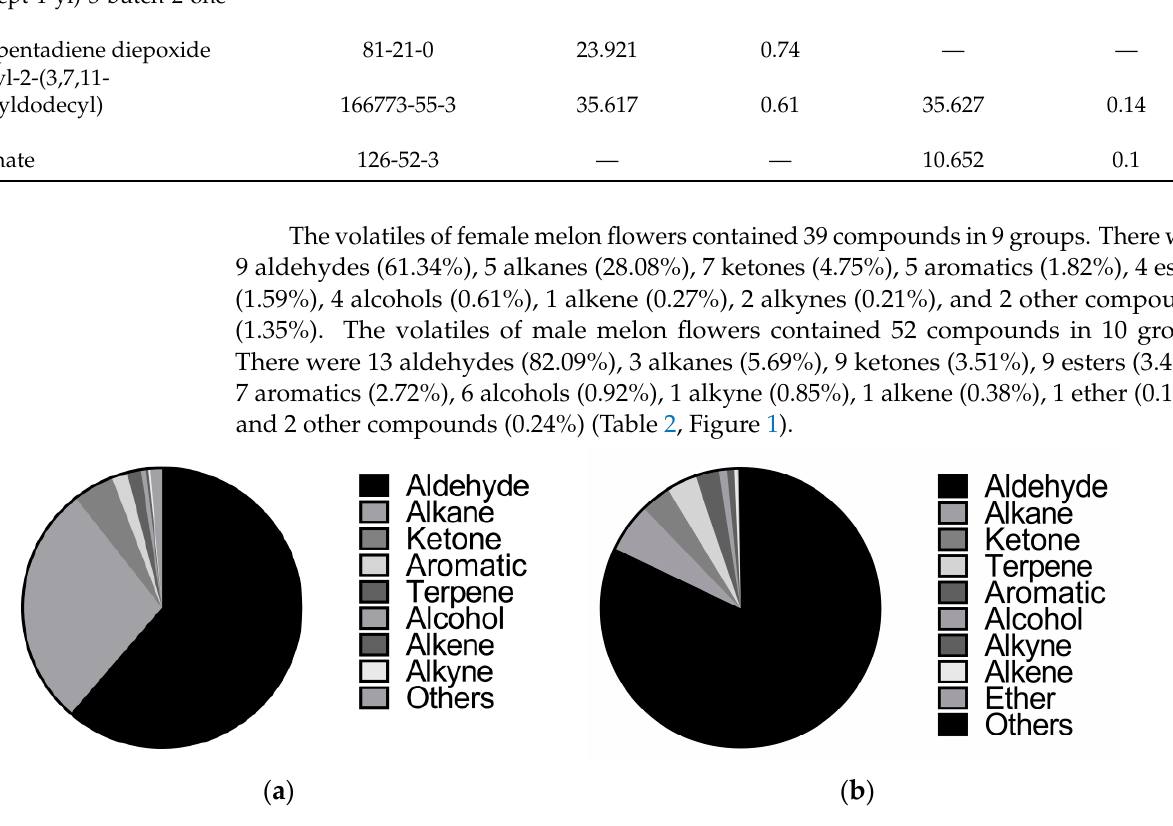
Figure 1. Proportion of volatile species in female and male flowers of melon. ( a ) Analysis of the proportion of volatile species in female flowers of melon; ( b ) analysis of the proportion of volatile species in male flowers of melon.